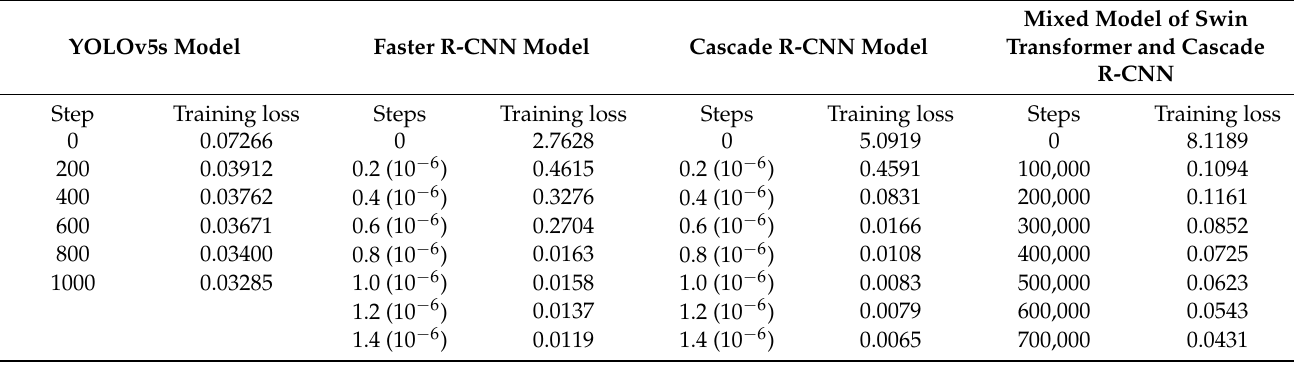
Table 3. Training the detection model for pine pests.